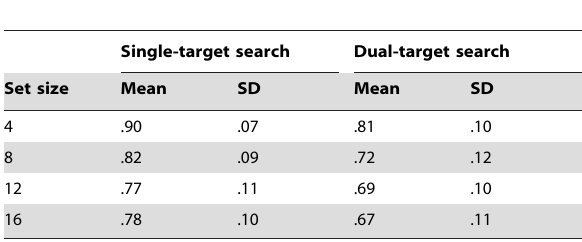
Table 2. Mean proportion of correct responses for single- and dual-target searches by set